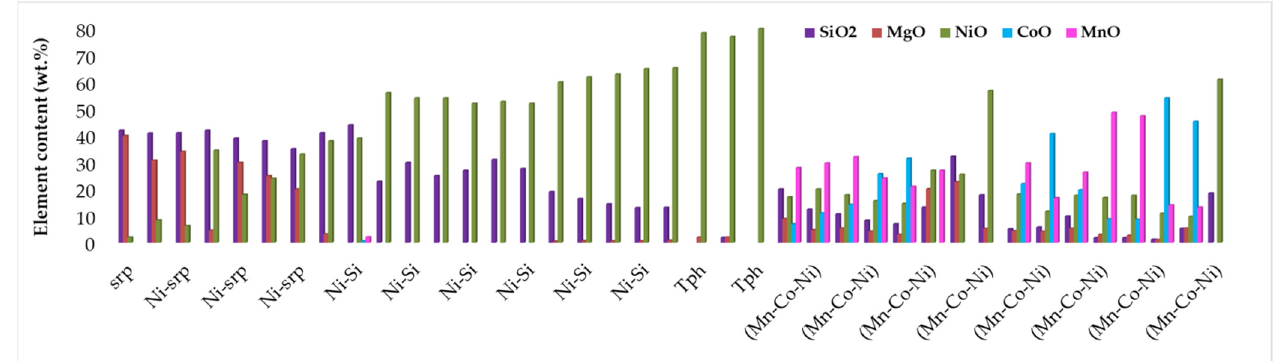
Figure 5. Variation in the SiO 2 , MgO, NiO, CoO and MnO contents, in serpentine (srp), Ni-serpentine (Ni-srp), Ni-silicides (Ni-Si) and (Mn, Co-Ni)-hydroxides, hosted in metamorphosed Ni-laterite samples from Vermion ophiolite. Symbols: as in Figure 3. Data source: present study and Economou- Eliopoulos and Eliopoulos [12].